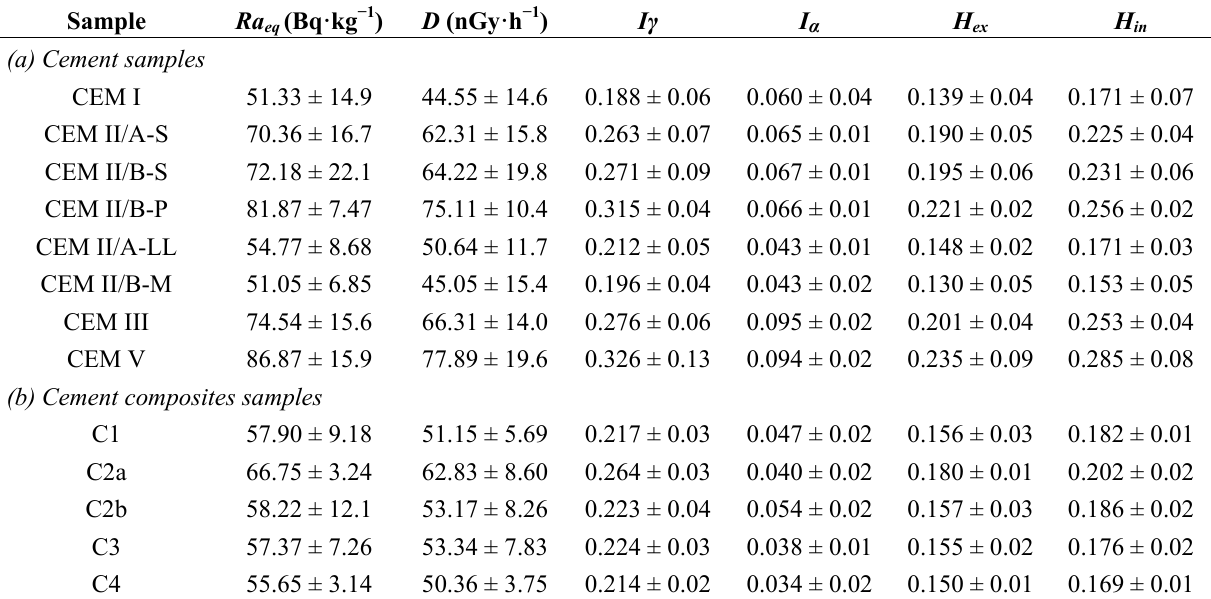
Table 6. The average values of radiation hazard parameters for studied cement and cement